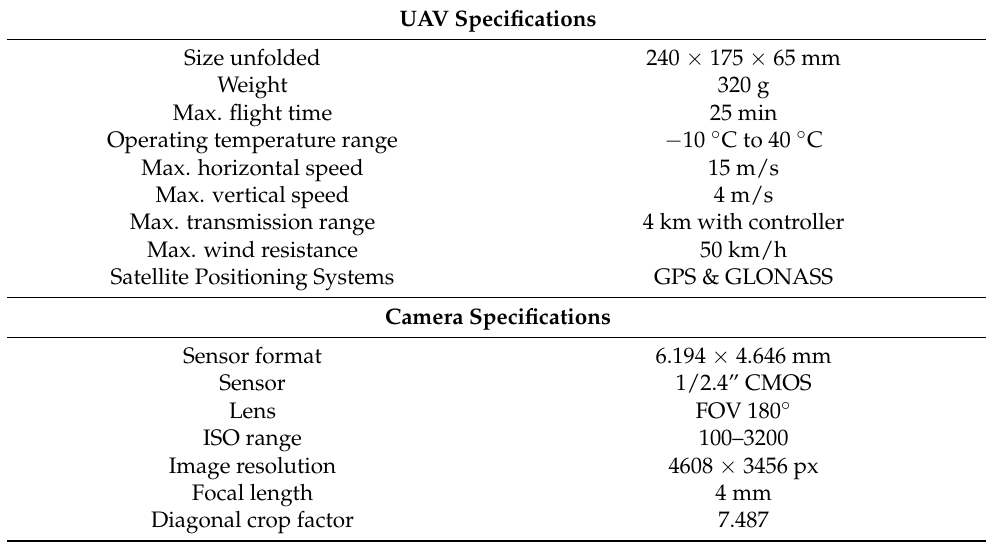
Table 1. Technical specifications of the Parrot ANAFI drone used in the case study [32].